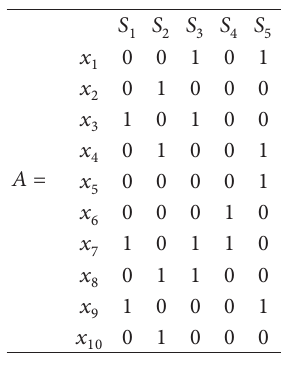
Table 1: Incidence matrix